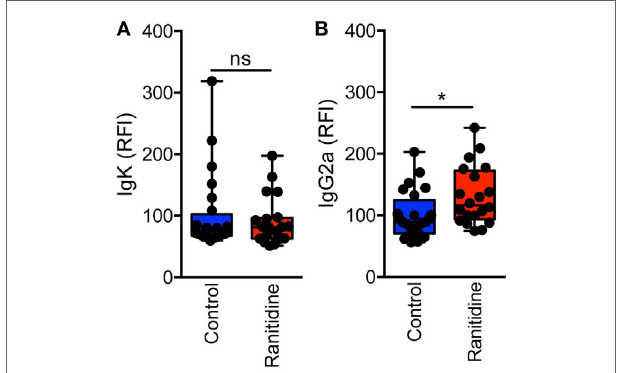
FigUre 1 | Alterations in anti-GFP IgG1 and IgG2a antibody in ranitidine- treated E0771-GFP tumor-bearing mice. Plasma from C57BL/6 and CCR2 − / − tumor-bearing mice (treated and non-treated) were serially diluted and an enzyme-linked immunosorbent assay was used to detect GFP- specific IgG1 (a) or IgG2a (B) . Data points represent mean ± SEM of 10–34 mice. Significance was assessed using two-way ANOVA followed by uncorrected Fisher’s LSD multiple comparisons. * p < 0.01, ** p < 0.01, *** p < 0.001, and **** p <